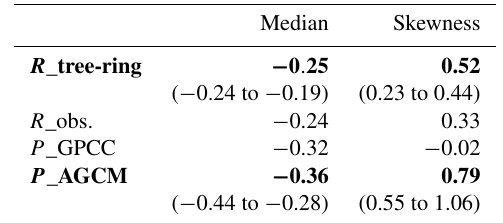
Table 2. Median and skewness of the 15-year running correlations for the tree-ring-reconstructed annual R (Fig. 2c), observed autumn R (Fig. 2a), observed summer P (Fig. 2b), and simulated summer P . The observed P and simulated P are based on the GPCC and AGCM. A histogram and scatter diagram for these values are shown in Fig. 3a and b. Values in brackets indicate the range of statistics calculated from five (15) subsets of 150-year records for the recon- structed R (simulated P ). The results with bold values are robust based on the long-term